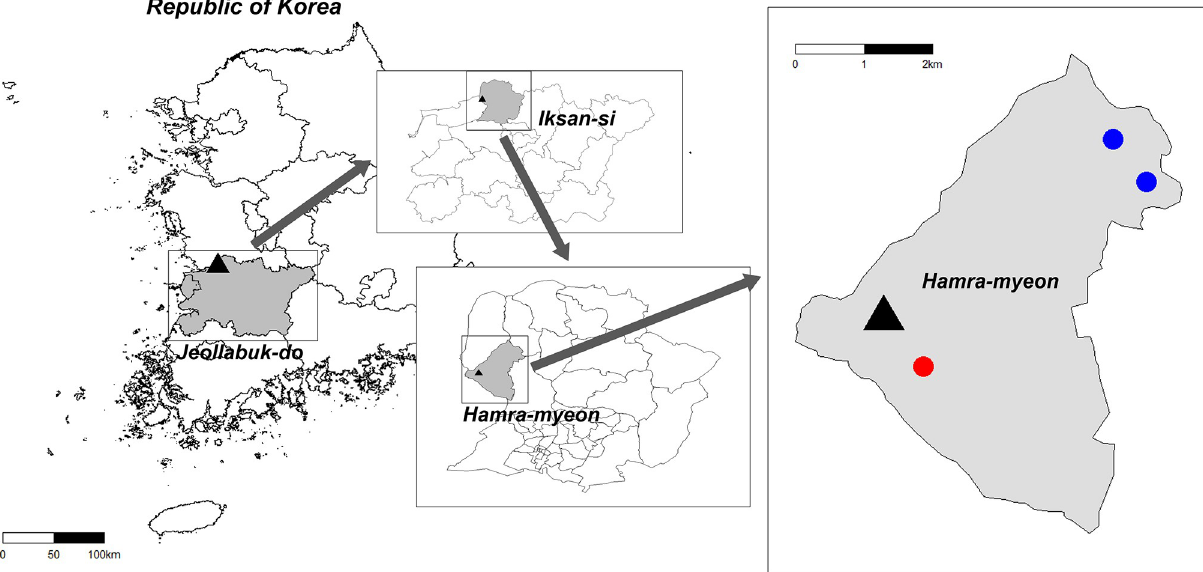
Fig 2. The map of study area, Hamra-myeon, Iksan-si, Jeollabuk-do, South Korea. Jeollabuk-do is a province located in the southwest of South Korea. Iksan-si is a city located in the northwest of Jeollabuk-do. Hamra-myeon is one of sub-administrative districts of Iksan-si, located in the west of the city. The black triangle indicates the fertilizer factory near Jang-jeom village marked with red dot, and two blue dots indicates Ganseong (upper) and Topgoji villages (lower), which are also located in Hamra-myeon, but thought to be not affected by the pollutants emitted from the plant.